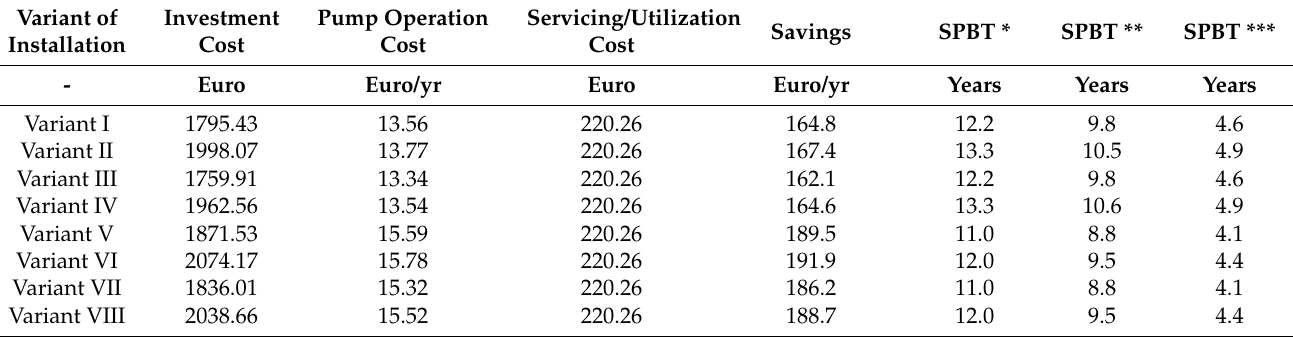
Table 2. Results of economic evaluation for the analyzed system